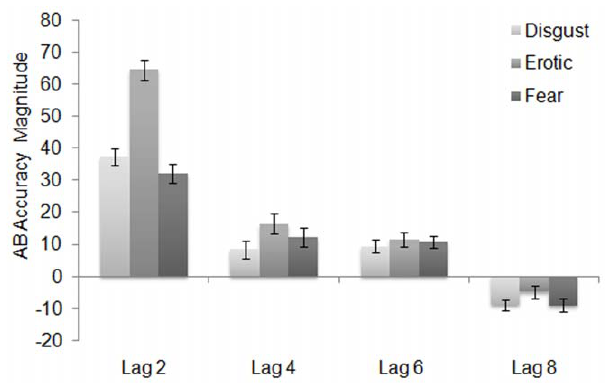
Figure 3. Attentional blink magnitude scores for each emotion category by lag, error bars represent standard error of the